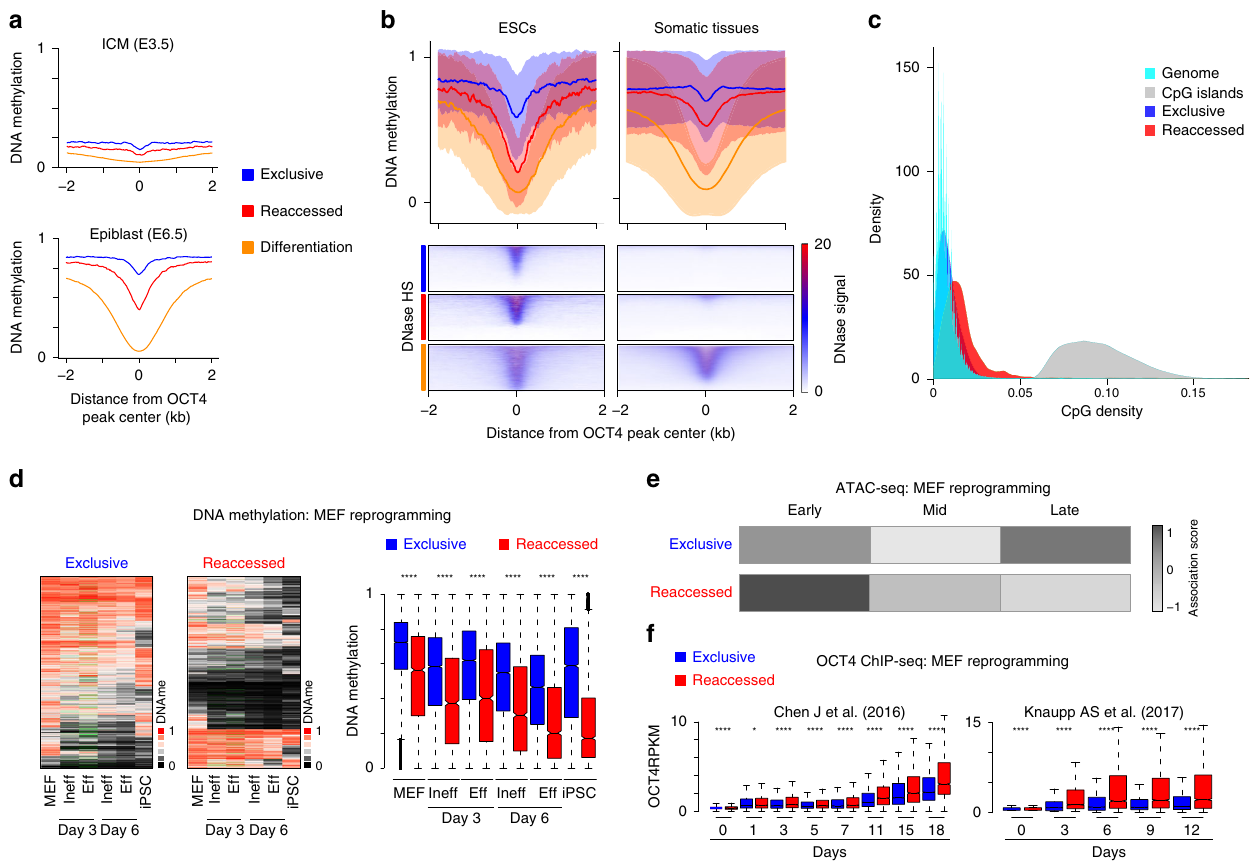
Fig. 5 Accessible OCT4 targets retain a residual epigenetic signature over differentiation. a CpG methylation levels of exclusive, reaccessed, and differentiation-associated OCT4 targets during early development in vivo. Composite plots of mean DNA methylation (WGBS data) are shown for E3.5 ICM and epiblast (E6.5). Differentiation-associated OCT4 peaks are shown for comparison. b Reanalysis of WGBS (upper panel) and DNase hypersensitivity data from ENCODE (lower panel) for OCT4 peaks in ESCs and six somatic tissues, shown as “ somatic average ” 31,33,62 . Peaks were extended to ±2 kb from the center before calculating the average signal. Lines indicate the median values for each set while shaded areas represent ±1 standard deviation. c Histograms of CpG density within 1 kb genomic tiles, annotated CpG islands, and OCT4 peaks, either exclusive or reaccessed (mean/median CpG counts per 100 bp: 8.01/6, 67.65/54, 5.67/5, and 11.65/9, respectively). d Heatmaps show DNA methylation changes during MEF reprogramming at exclusive and reaccessed regions 35 . OSKM induced MEFs were divided into ef fi cient (Eff) and inef fi cient (Ineff) reprogramming populations based on established markers prior to methylation pro fi ling. On the right panel, the WGBS data is represented as boxplot. Horizontal black lines indicate medians; boxes show central 50% of data and whiskers indicate 25 th and 75 th percentile data. Mean methylation at our regions of interest required a minimum of 1 CpG of at least 3x coverage and green indicates insuf fi cient coverage. P values are calculated using Mann-Whitney test: **** p < 0.0001. e Heatmap of the association score (row normalized) between exclusive, and reaccessed OCT4-binding regions with regions that become accessible during early, middle or late stages of MEF reprogramming (based on a recent study 6 ). The signi fi cance (the association score) is calculated using the regioneR package 60 . f OCT4 enrichment for exclusive and reaccessed regions during MEF reprogramming (reanalyzed ChIP-seq data from Refs 7,32 ). Horizontal black lines indicate medians; boxes represent interquartile range showing central 50% of data and whiskers indicate 25 th and 75